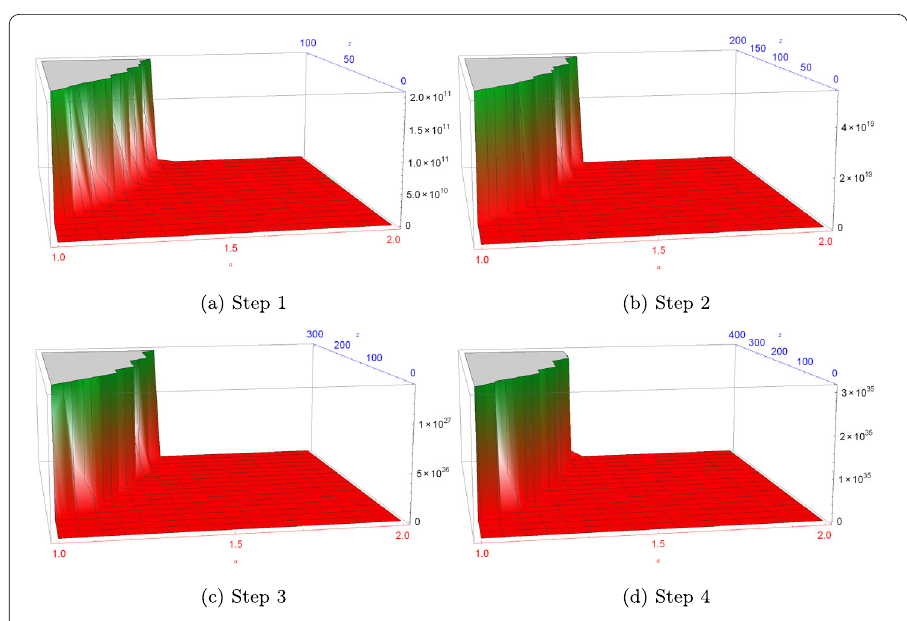
Figure 1 Step by step growth of the Mittag-Leffler function E A , B ( z ) with respect to the growth of z